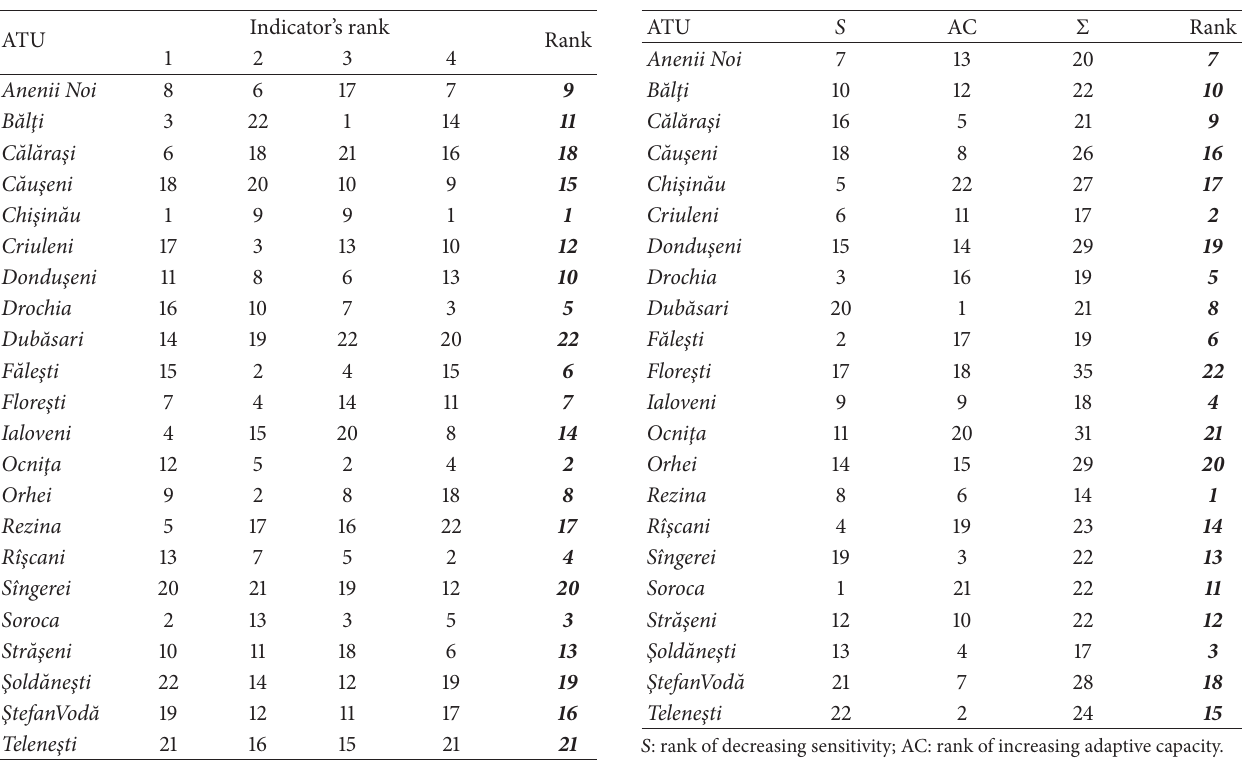
Table 6: Ranks of Moldova’s administrative-territorial units in the decreasing order of their